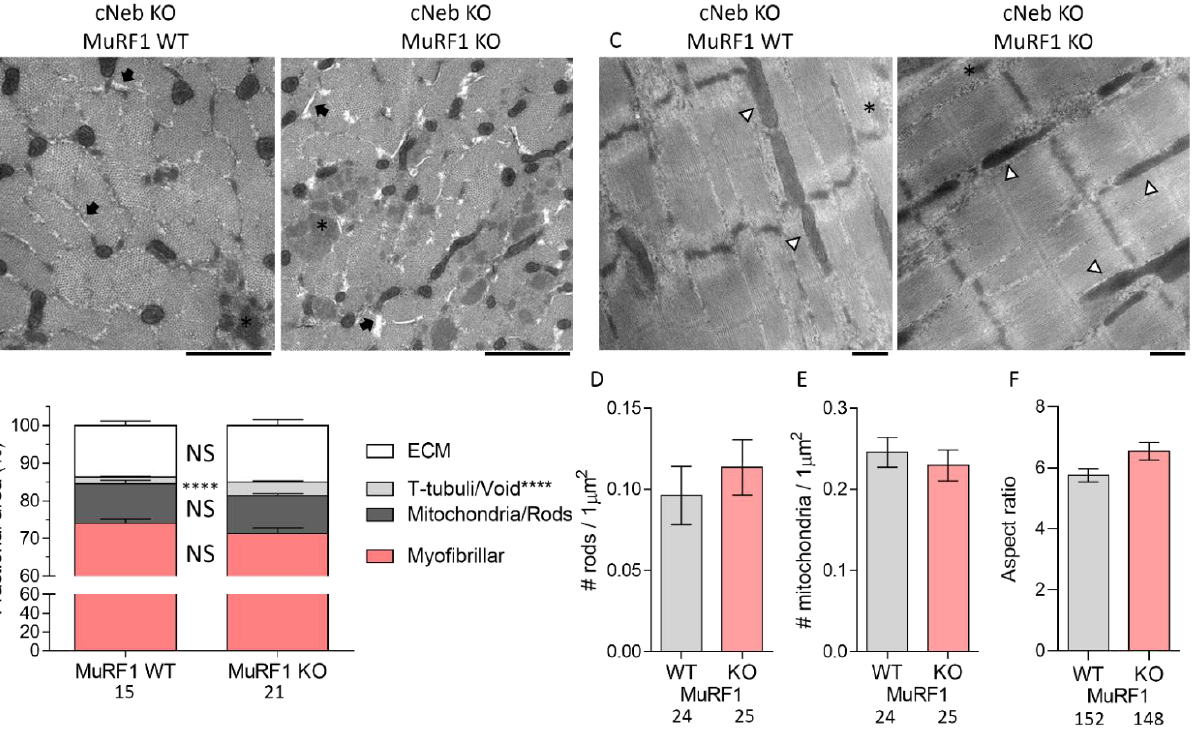
Figure 7. Electron micrographs of gastrocnemius muscles from conditional nebulin KO crossed with MURF1 KO mice. ( A ) Representative cross-sectional electron micrographs. Scale bars: 1 μm. ( B ) Quantified fractional cross-sectional area of compartments. ( C ) Representative longitudinal electron micrographs. Scale bars: 500 nm. ( D ) Number of nemaline rods per square micrometer. ( E ) Number of mitochondria per square micrometer. ( F ) Aspect ratio (length divided by width) of mitochondria. Asterisks show nemaline rod bodies. Arrows indicate T-tubules and void areas. Arrowheads point to mitochondria. Arrow heads indicate mitochondria. Numbers indicate number of analyzed images (mitochondria in ( F )) from two mice for each genotype. Hierarchical t-tests were used for statistical testing **** p < 0.0001.